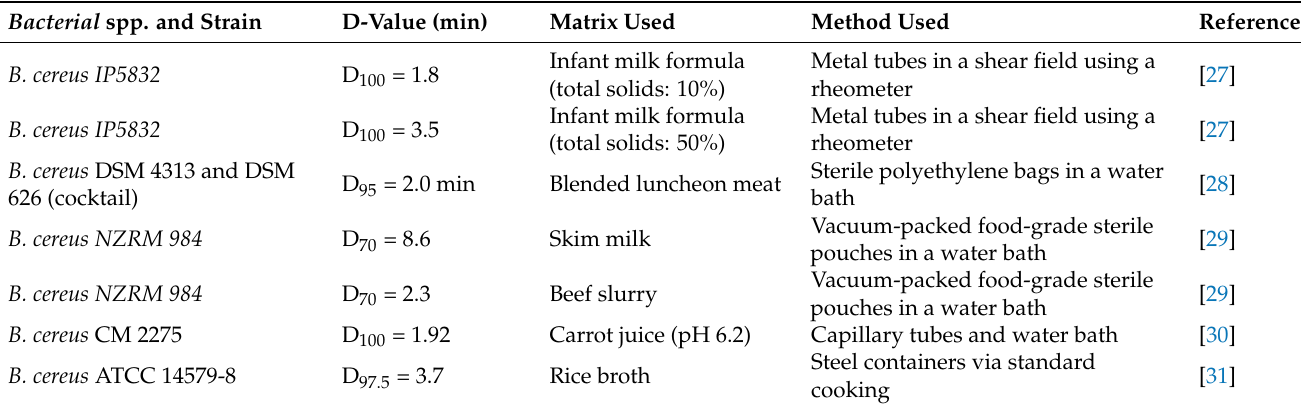
Table 2. D-values (thermal resistance) for B. cereus spores and the food matrix used. Bacterial spp. and